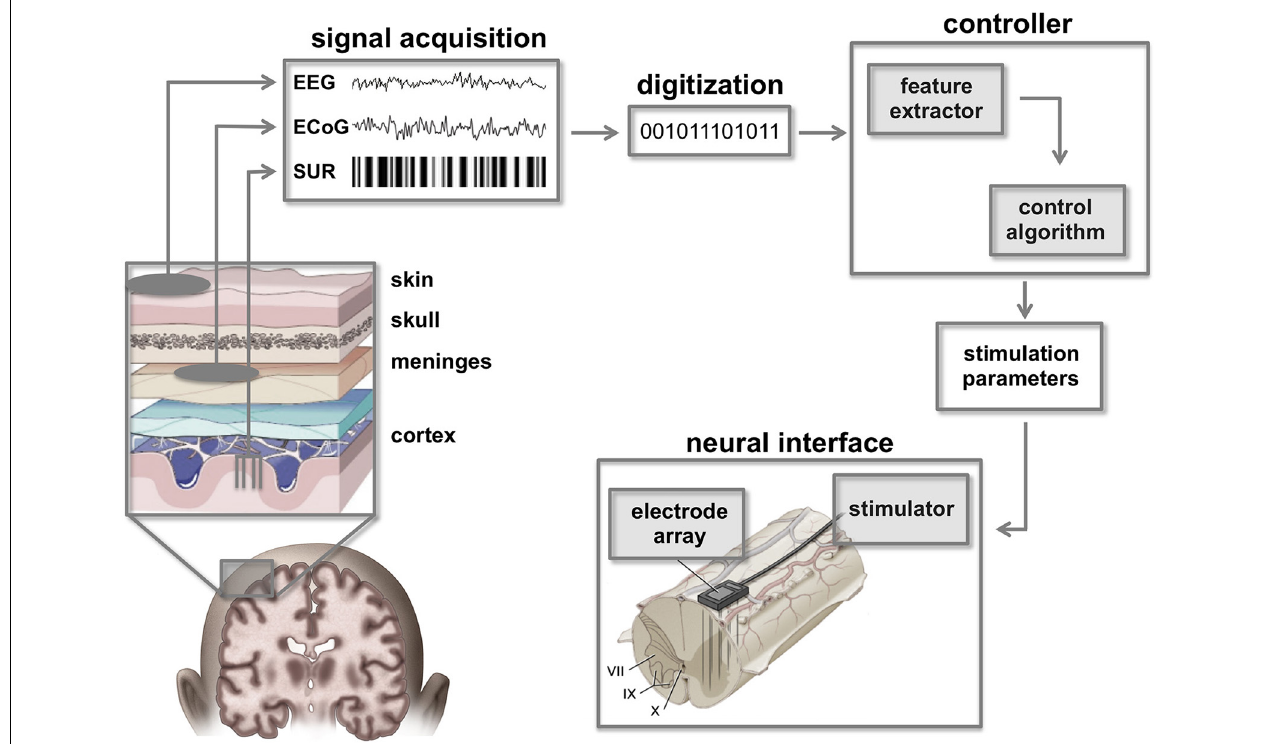
FIGURE 3 | Cortico-spinal neuroprostheses. Command signals from the brain can be extracted using a variety of brain signal recording techniques such as single unit recordings (SUR), electrocorticographic signals (ECoG), or electroencephalographic signals (EEG). Raw signals must be digitized and filtered to extract essential features that can